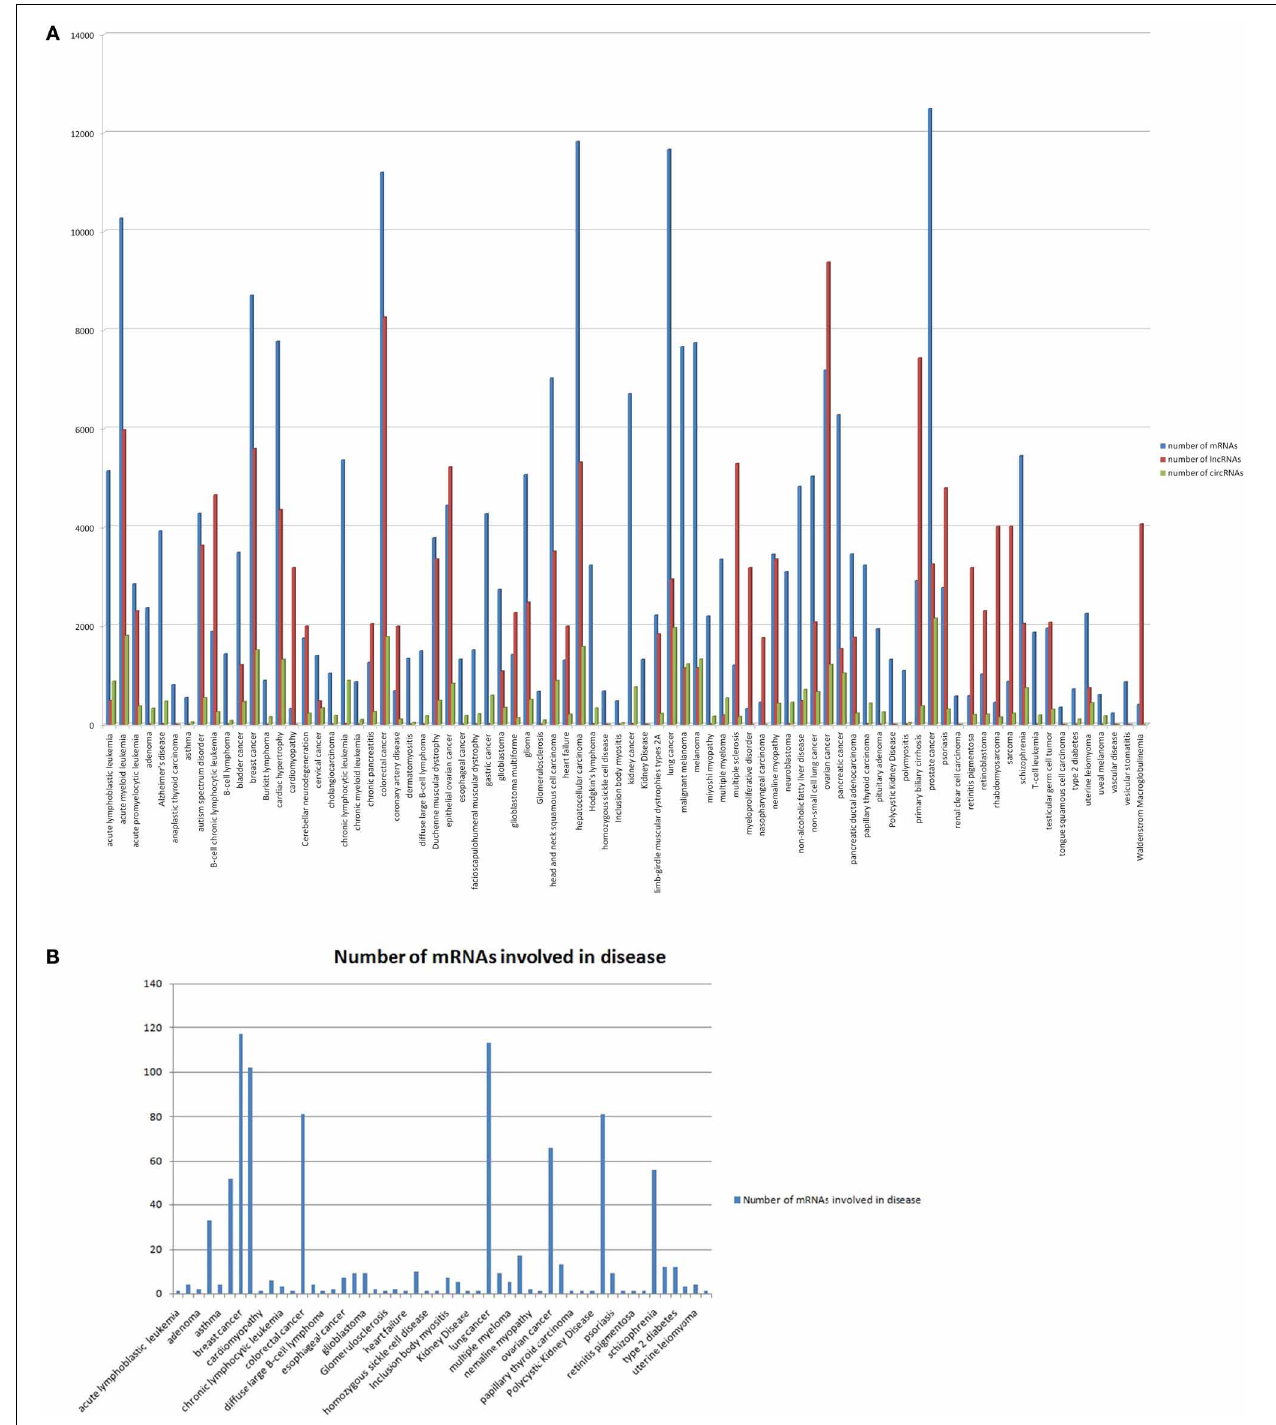
FIGURE 1 | (A) The number of mRNAs (blue), lncRNAs (red), and circRNAs (green) interacting with miRNAs associated with individual diseases. The number of mRNAs, lncRNAs, or circRNAs is plotted along the Y-axis, while the X-axis shows the individual disease